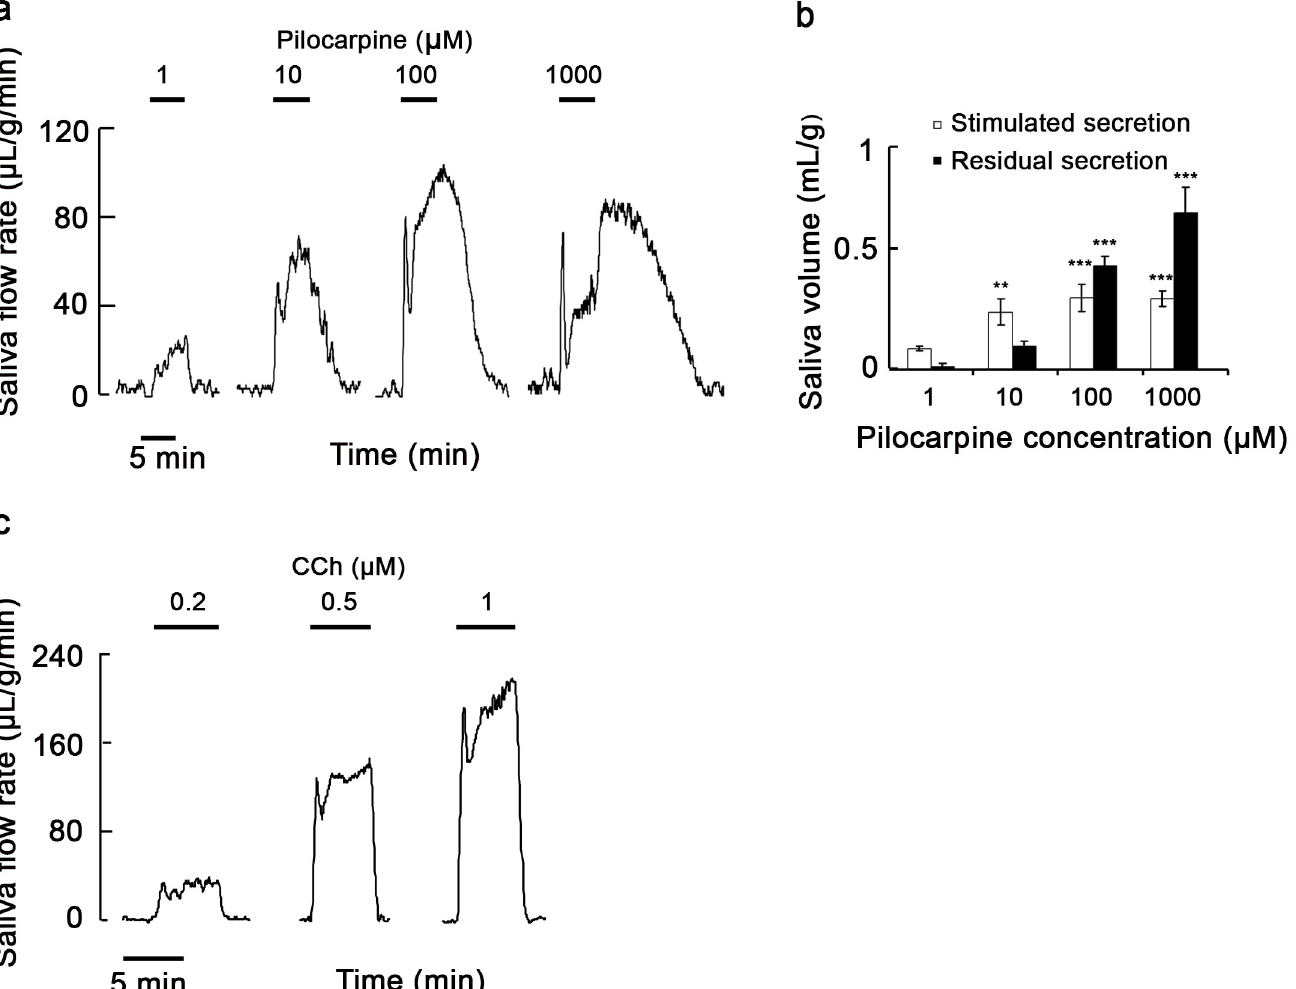
Fig 1. Presence of residual secretion of salivary fluid induced by pilocarpine in perfused submandibular glands of rats. (a, c) Profile of residual secretion of salivary fluid induced by pilocarpine (a) or carbachol (c). Submandibular glands were stimulated with 1–1000 μ M pilocarpine or 0.2–1 μ M carbachol (CCh) for 5 min. Stimulating periods are indicated as black bars. Results are representative of three independent experiments. (b) Stimulated and residual salivary fluid secretion induced by various concentrations of pilocarpine. Data are means ± S.E. of three independent experiments. �� , P < 0.01 and ��� , P < 0.001 compared with unstimulated